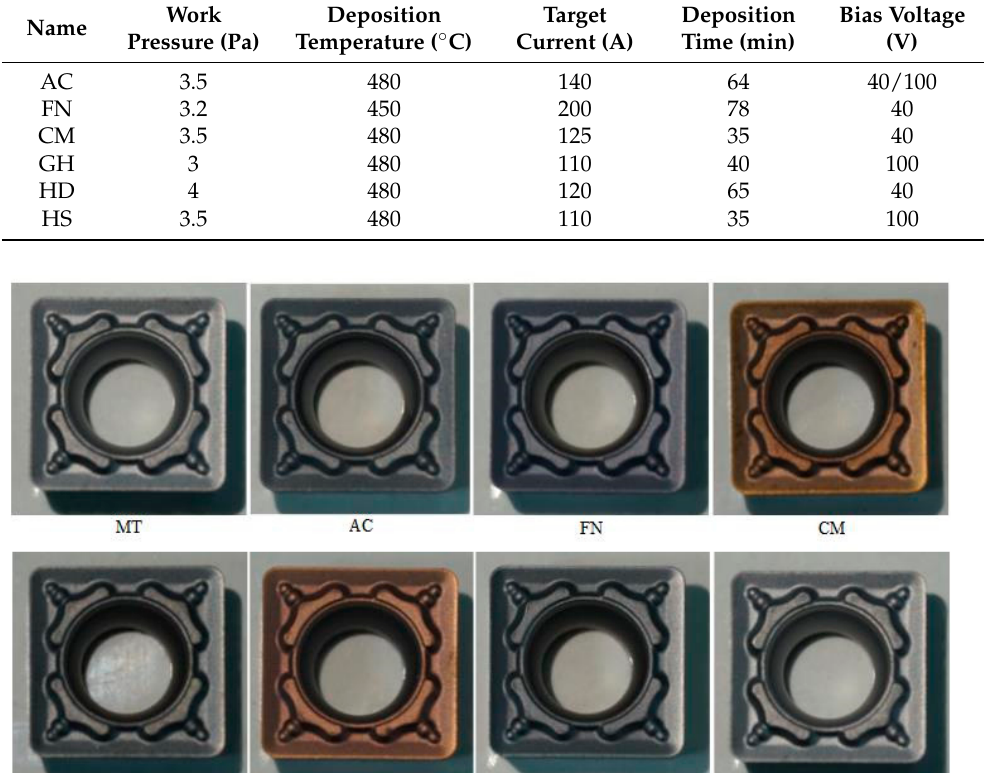
Table 2. Processing parameters of tested coatings.